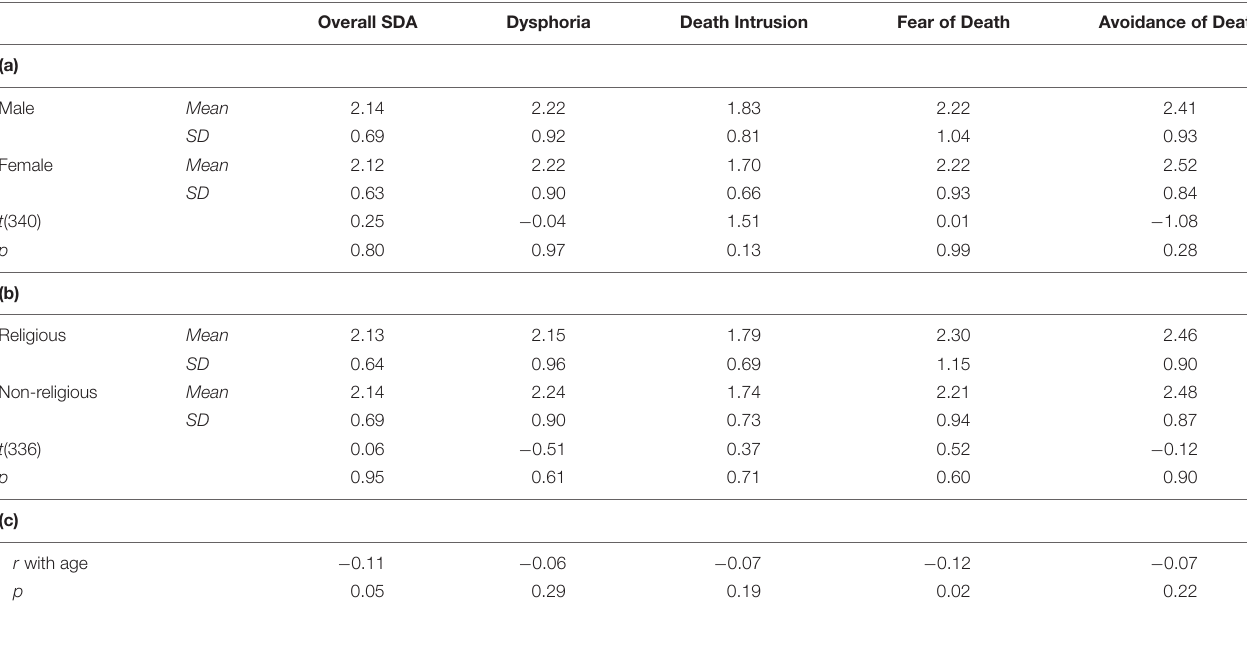
TABLE 4 | Effects of gender (a), religion (b), and age (c) on the overall and four dimensions of